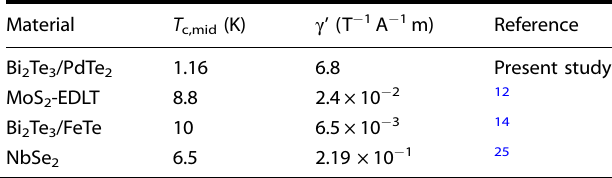
Fig. 2 Nonreciprocal transport under in-plane magnetic fi eld. a Schematic illustration of the measurement con fi guration. b , c Magnetic fi eld dependence of R ω ( b ) and R 2 ω ( c ) at various temperatures. d Color plot of γ as a function of magnetic fi eld and temperature. γ is derived using p γ R ω BI 0 . Gray lines, respectively, show the curves with equal resistanc e of R ω = 1 and 120 Ω . e Temperature dependence of the relation R 2 ω ¼ 1 ffiffi 2 nonreciprocal coef fi cient γ at B = 0.02 T and I 0 = 10 μ A (black). The theoretical curve with the formula γ ¼ γ 0 ð T (cid:2) T BKT Þ (cid:2) 3 = 2 (green) is also plotted, where γ 0 = 380 T − 1 A − 1 K 1.5 . Table 1. Comparison of γ ’ in 2D